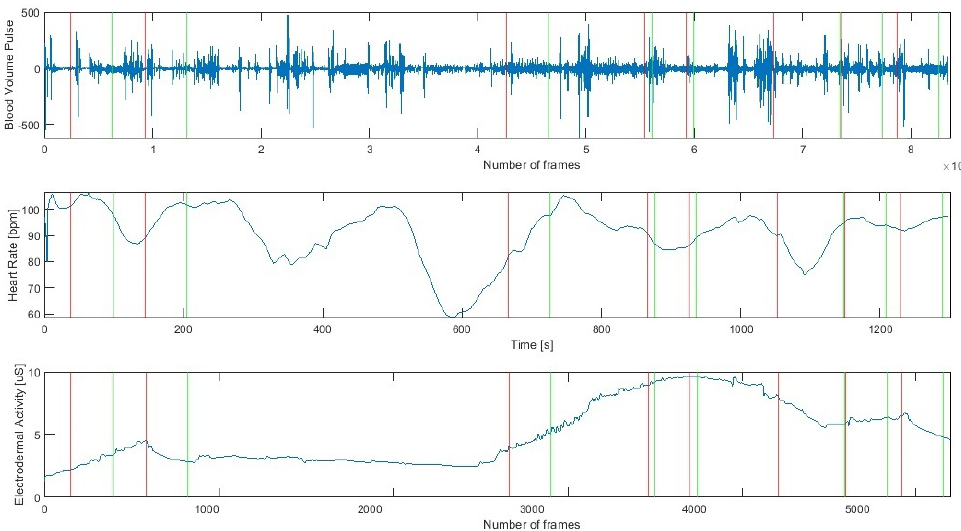
Figure 3. Cardiac (Heart Rate, Blood Volume Pulse) and Electrodermal Activity raw signals during successive stages of the research protocol (a red line indicates the beginning and a green line the end of a